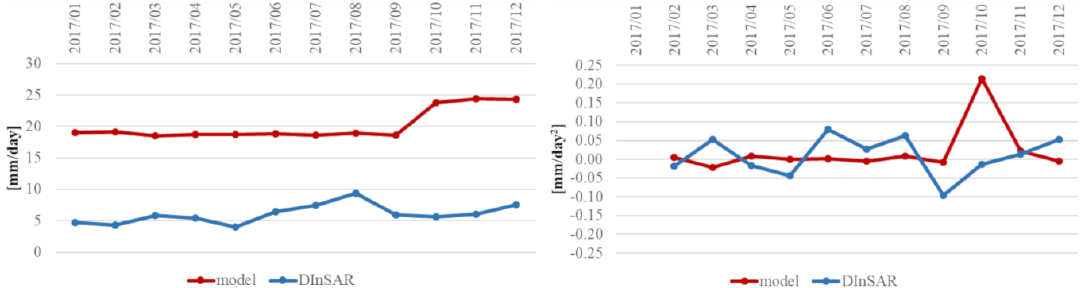
Figure 19. Velocity ( left ) and acceleration ( right ) of the subsidence for the extremal points by months.